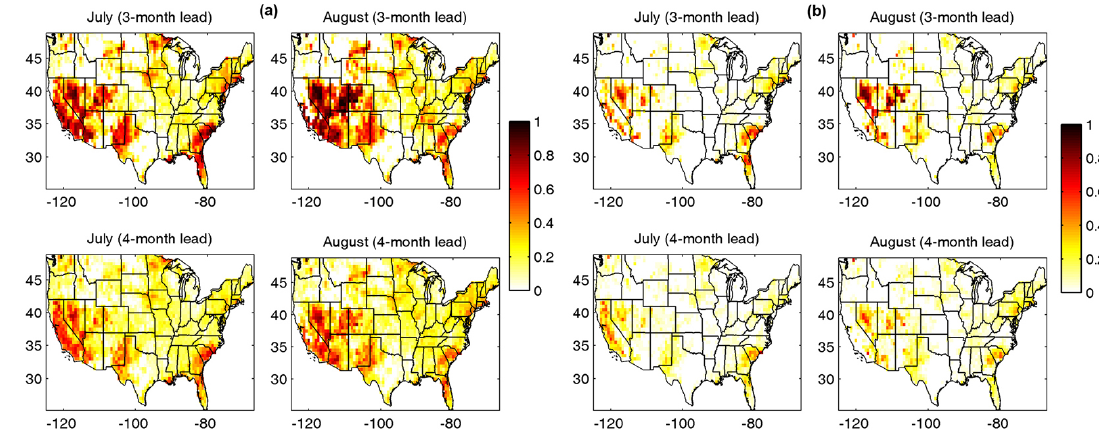
Figure 5. The 3- and 4-month lead time predictions of drought probability for July–August 2012; (a) SSI6 < − 0 . 8; (b) SSI6 < − 1 .